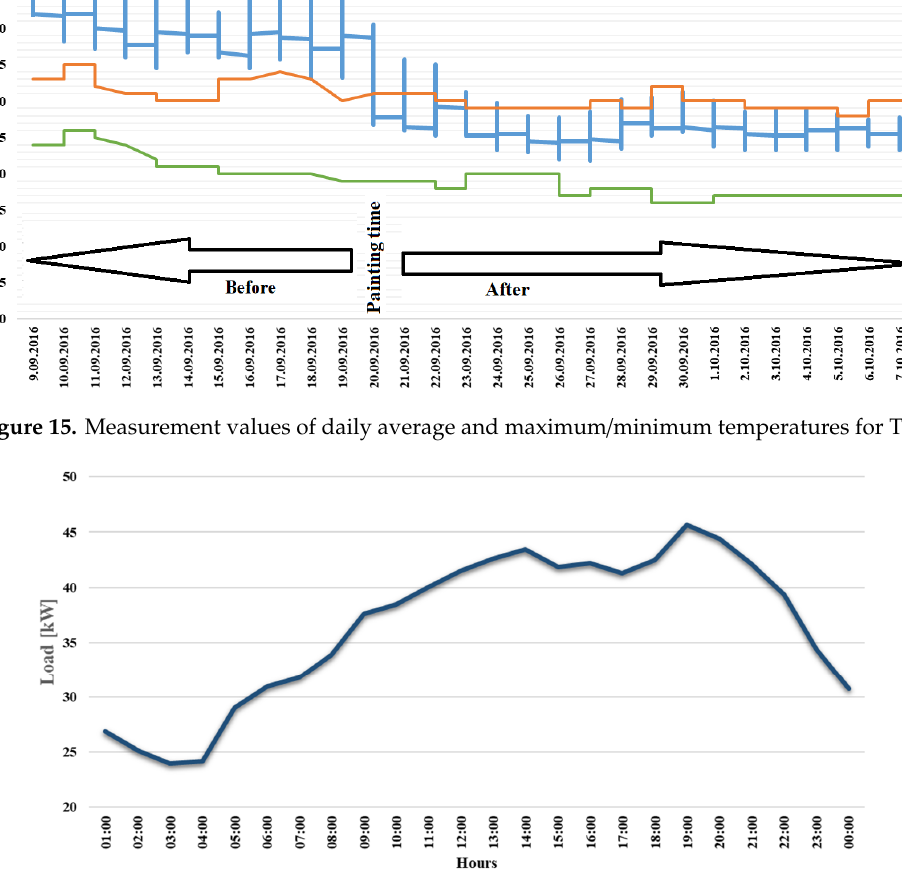
Figure 16. Daily load profile of TR5.